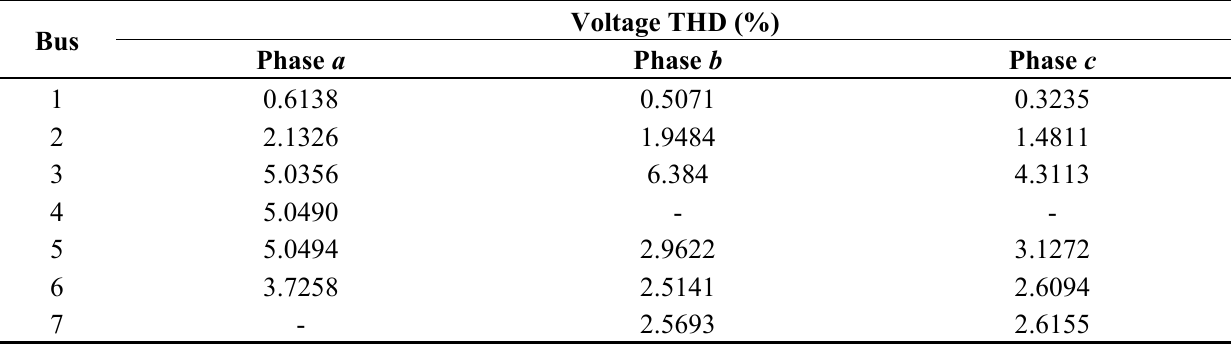
Table 7. Voltage THD (%) of a simple seven-bus test system with substation